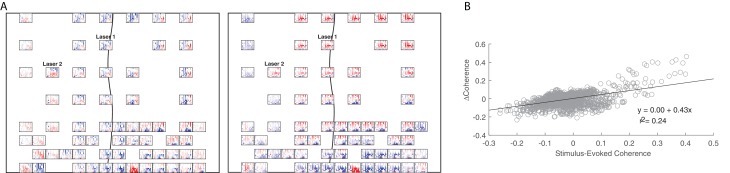
Short-latency example showing the relationship between input coherence and change in baseline coherence.(A) An example showing similarity between the input coherence (right panel) and the change in baseline coherence (left panel) in monkey J. Same as Figure 6A. (B) Linear regression between input coherence and the change in baseline coherence for the example session shown in A.10.7554/eLife.31034.029Figure 7—figure supplement 1—source code 1.Comparing pairwise coherence measurements for example session and regression parameters for all sessions by experimental condition.10.7554/eLife.31034.030Figure 7—figure supplement 1—source data 1.Pairwise coherence measurements for example session and regression parameters for all sessions by experimental condition.